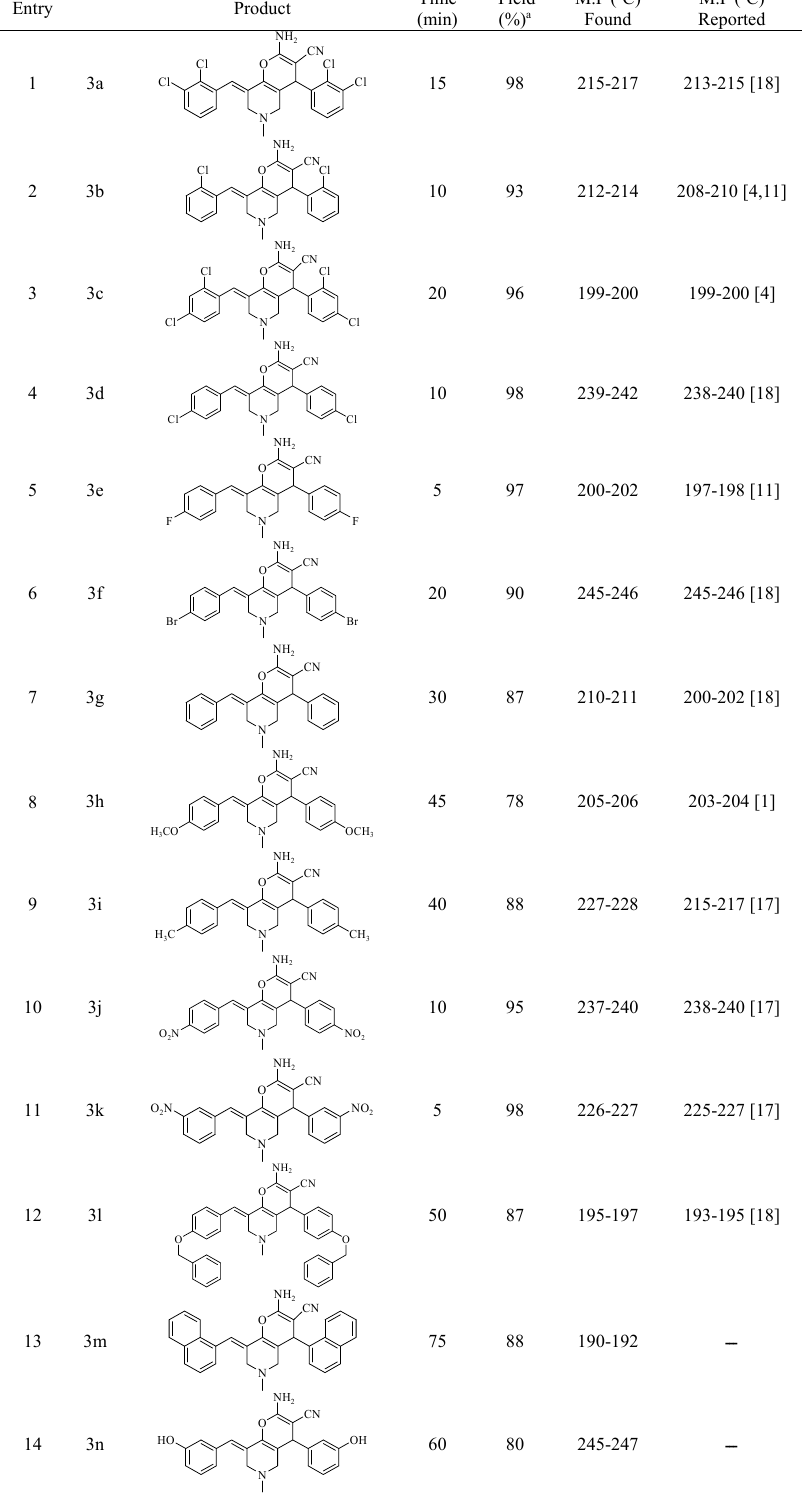
O -GO-NH as 3 4 2